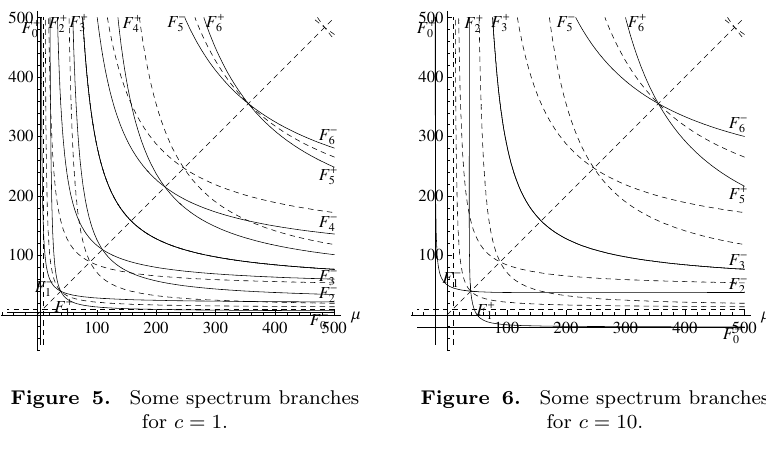
Figure 5. Some spectrum branches for c = 1.